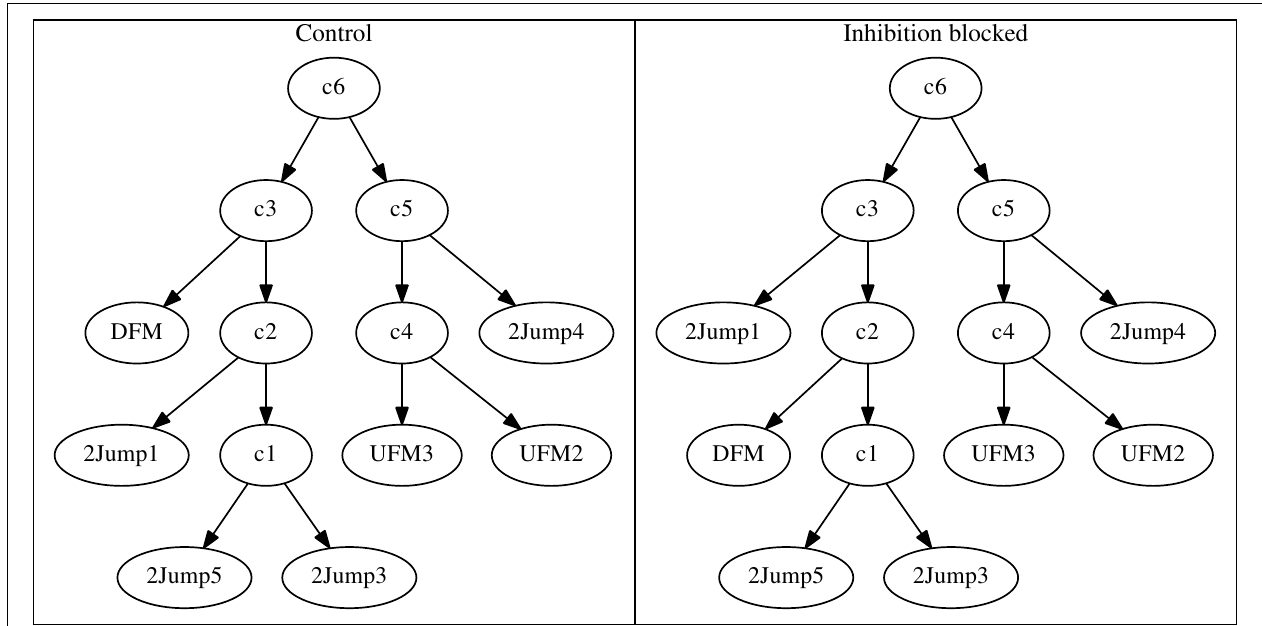
FIGURE 11 | Truncated response tree of modified neuron from Figure 9. While the whole clustering tree (not shown) was relatively inconsistent, the truncated tree containing only the most robust classes showed consistent responses to specific classes of